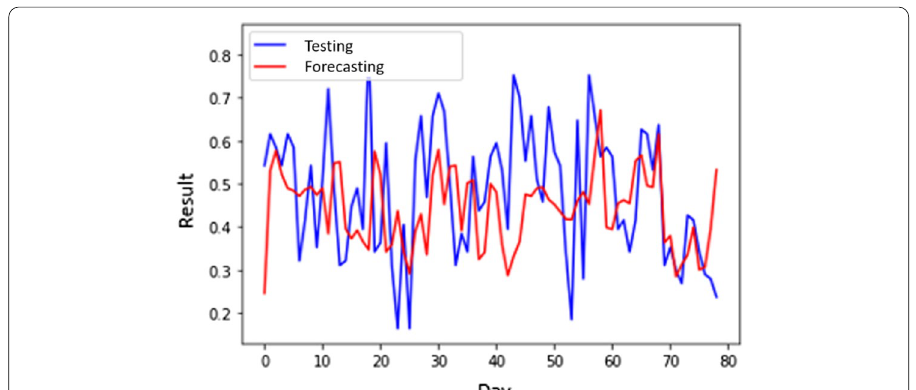
Fig. 5 The forecasting results of CNN scenario 1